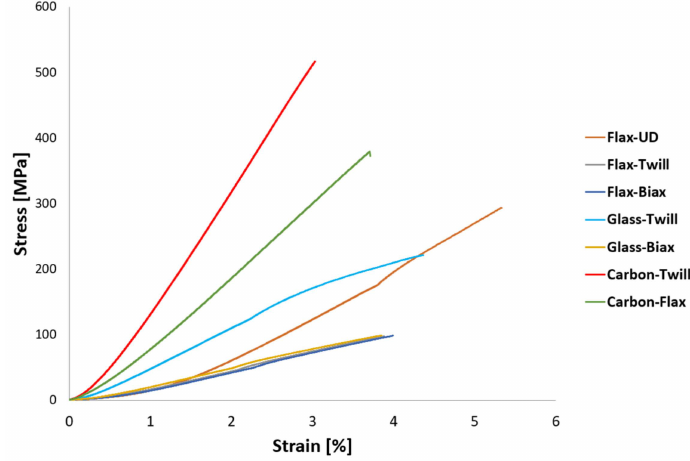
Figure 5. Tensile test results, stress-strain curves for test